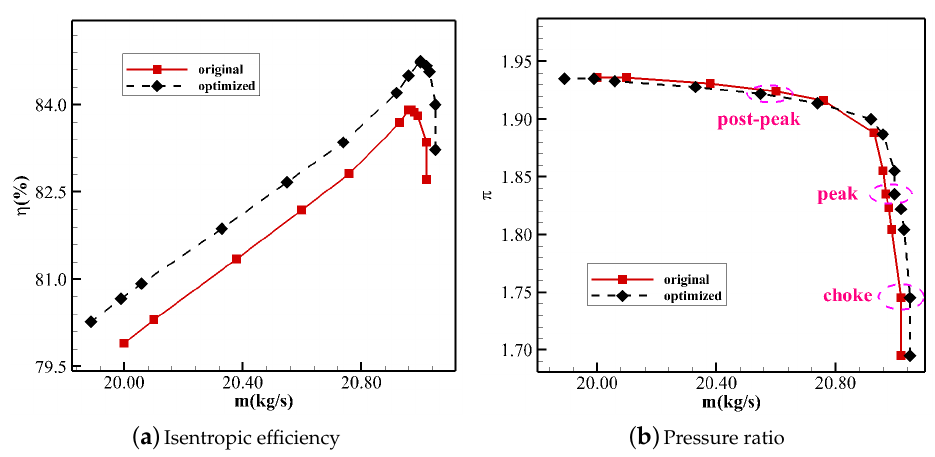
Figure 17. Comparison of performance characteristics at 100% design speed for the NASA Stage 35.